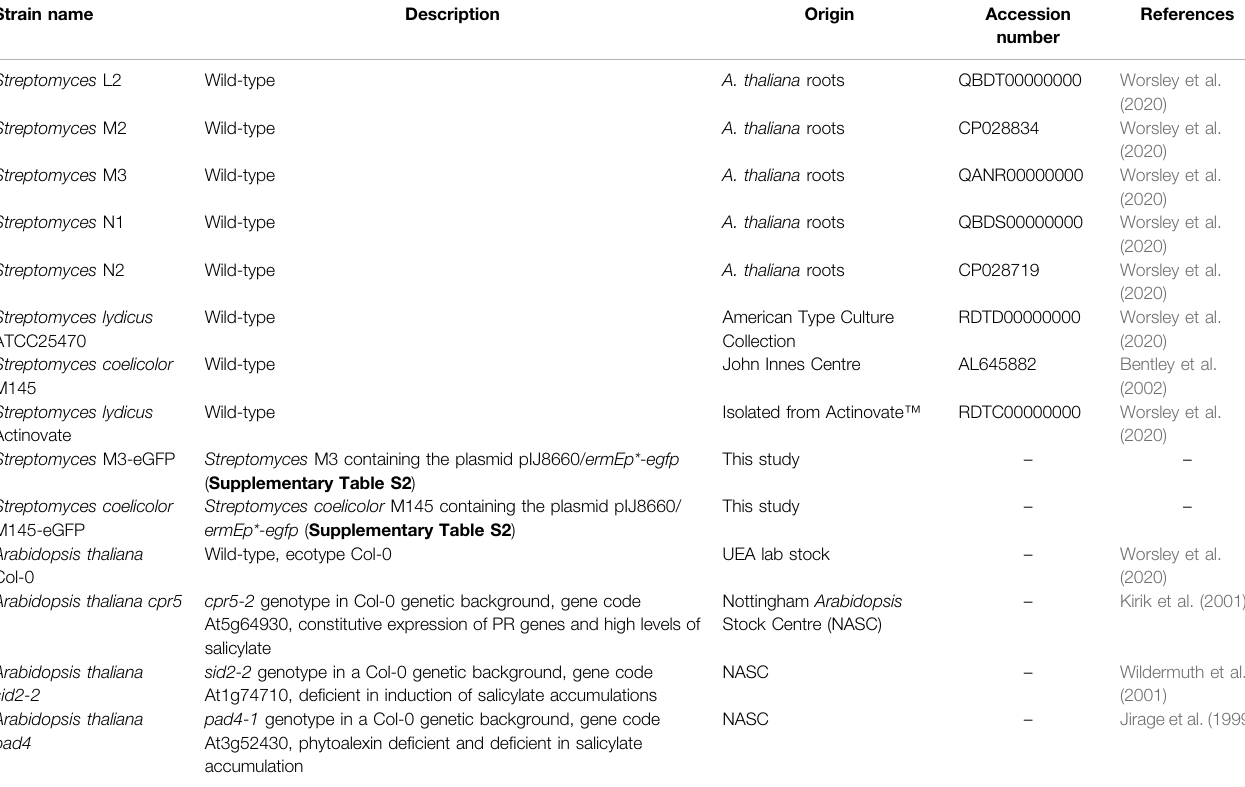
TABLE 1 | Bacterial strains and plants used in experiments.